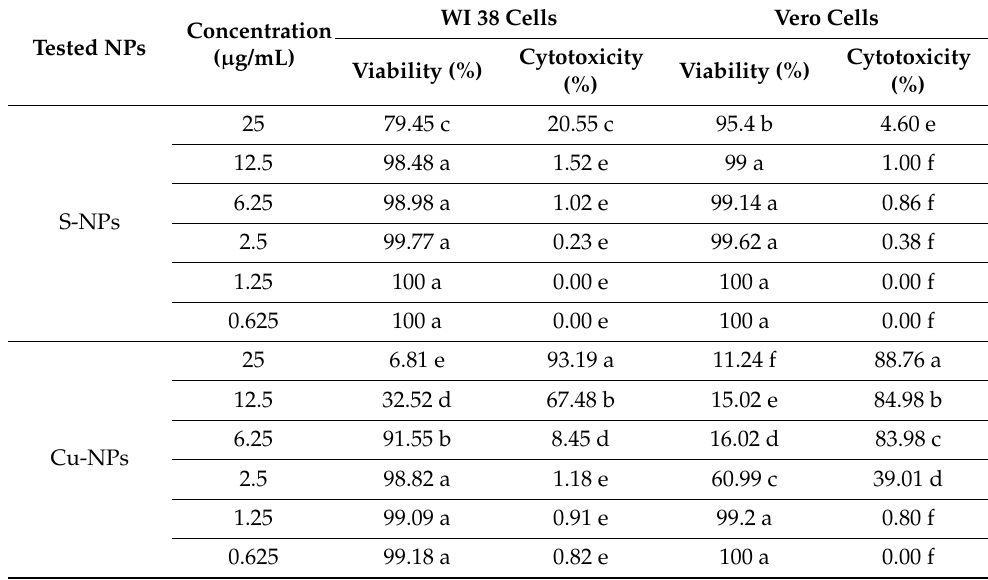
Table 4. Cytotoxicity levels of S-NPS and Cu-NPs on WI-38 and Vero cells.